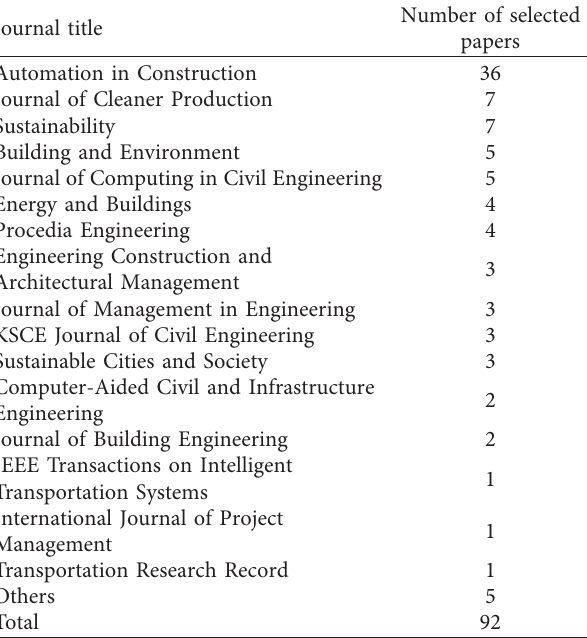
Table 1: Distribution of selected journal